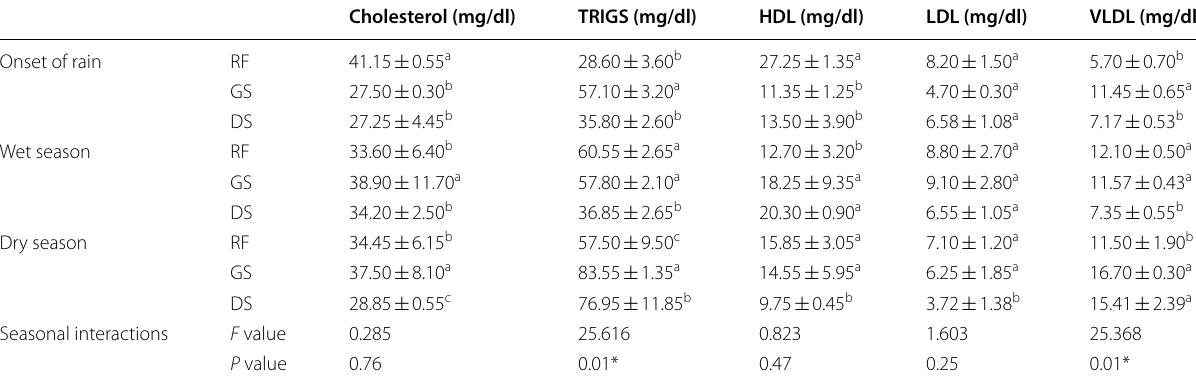
Table 6 Lipid profile (mg/dl) of the honeybees from the three ecological zones of Nigeria during the dry season, onset of rain and wet seasons